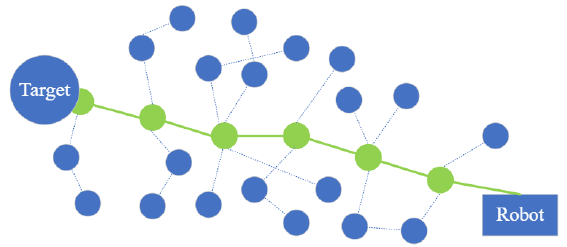
Figure 3. Demonstration of the RRT